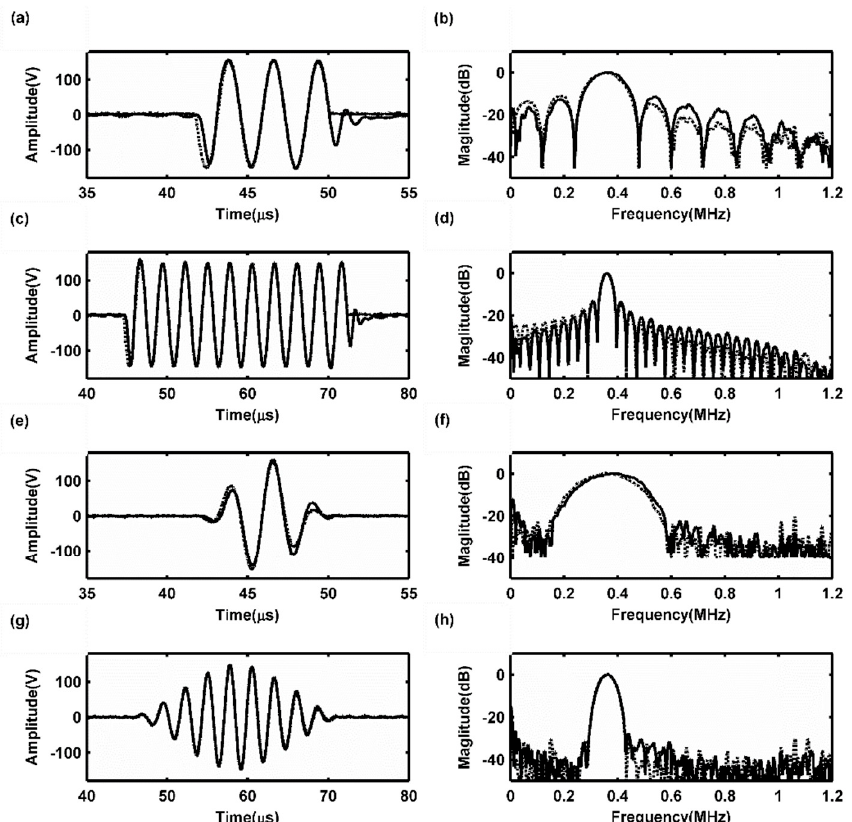
Figure 7. Output results of typical signals: ( a ) a 360-kHz three-cycle sine burst and its spectrum ( b ); ( c ) a 360-kHz ten-cycle sine burst and its spectrum ( d ); ( e ) a Hanning window function-modulated 360-kHz three-cycle sinusoidal signal and its spectrum ( f ); ( g ) a Hanning-window-function-modulated 360-kHz ten-cycle sinusoidal signal and its spectrum ( h ). Solid lines are measured values and dashed lines are ideal waveforms.